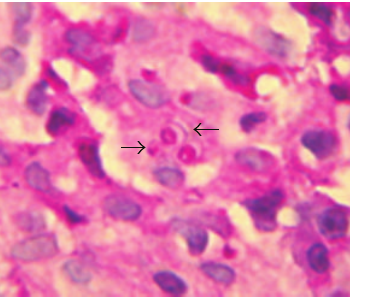
Figure 5: H&E 80x. Arrows showing intracellular Paracoccidioides